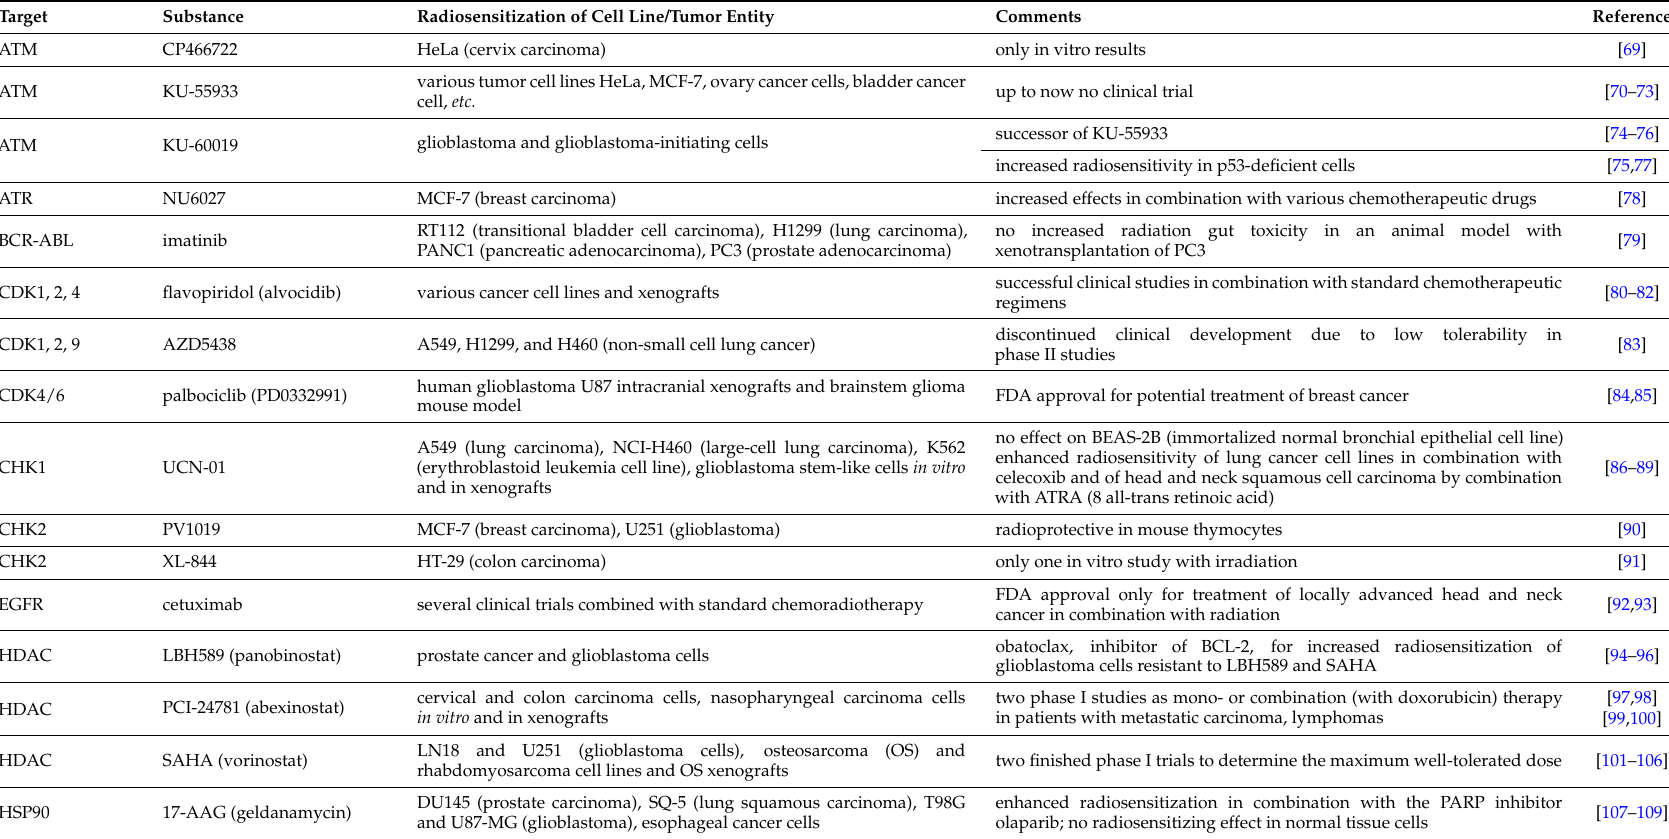
Table 1. Targets of radiosensitizing approaches and the effected pathways. Only those references are stated describing the combination with